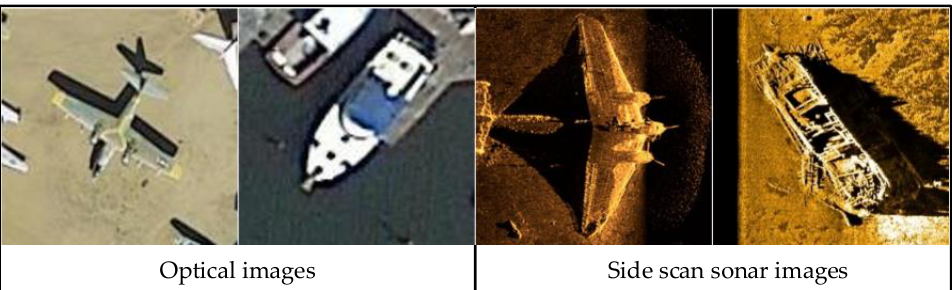
Figure 2. Samples of optical images and side-scan sonar images.